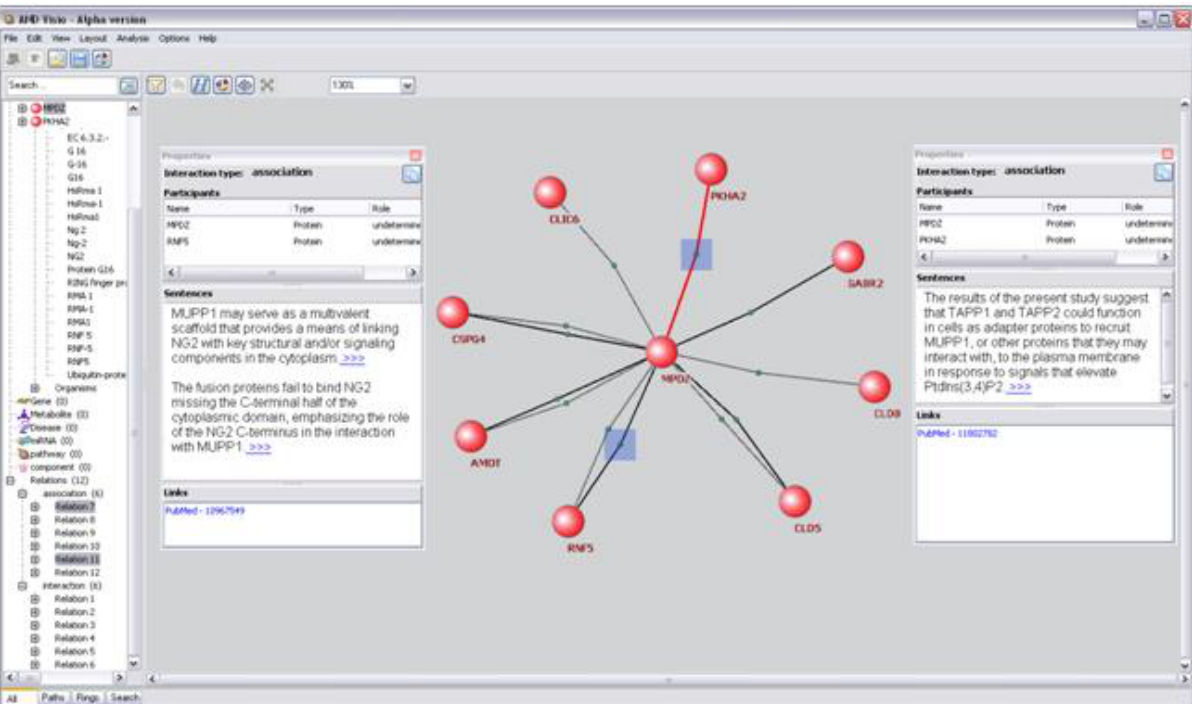
Figure 3. The MPDZ protein-protein interaction network based on PubMed abstracts in